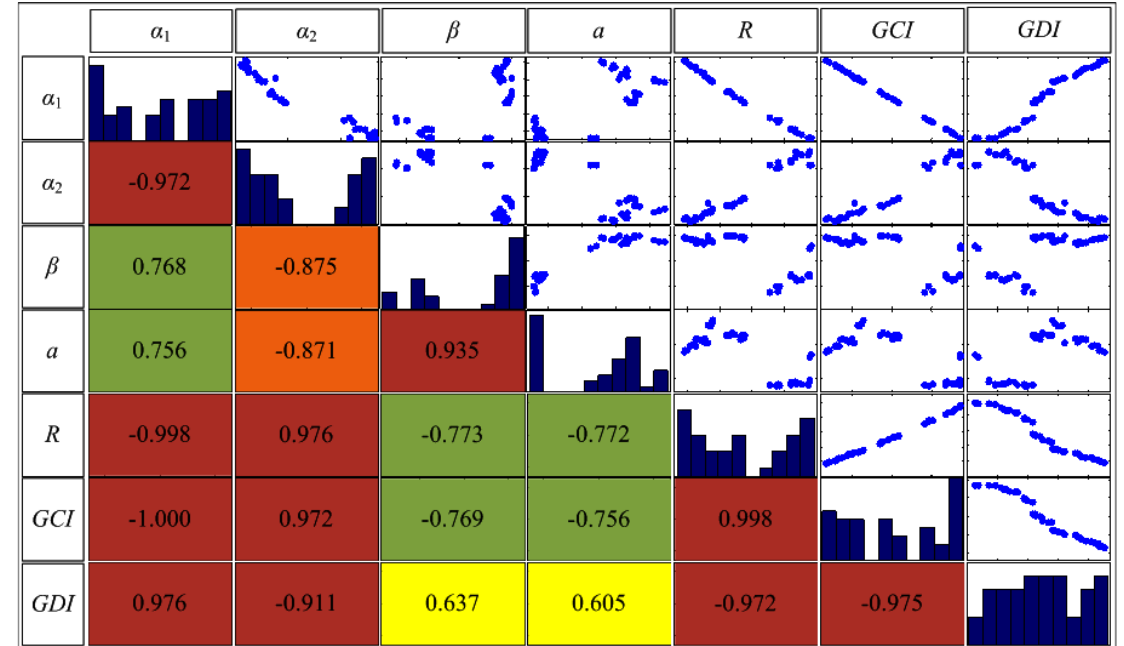
Figure 8: Scatter matrix for the objective functions and the design variables.